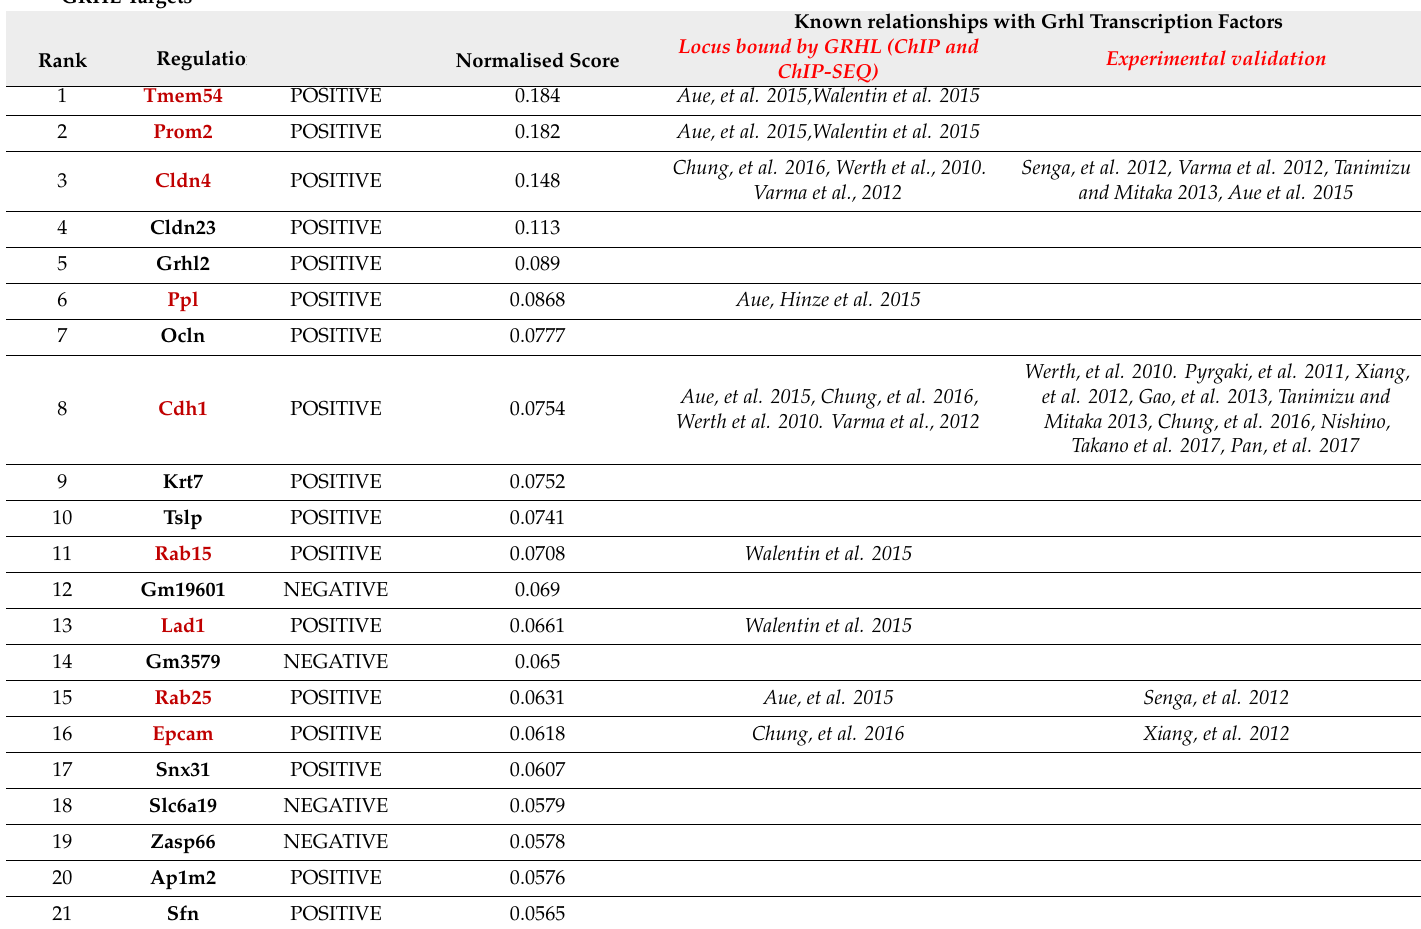
Table 2. The top 50 most di ff erentially regulated genes in all biological contexts following modulation of grh / Grhl function. The overall top 50 di ff erentially regulated (both positively and negatively) genes of grh / grhl as identified by analysis of all published Microarray and RNA-SEQ datasets. 15 out of the 50 predicted target genes had previously been validated in literature through either large-scale ChIP-SEQ genome mining experiments, or through experimental validation (highlighted in